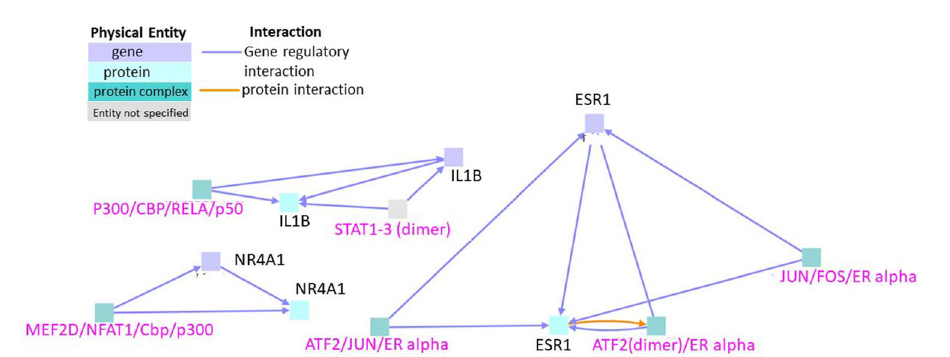
Figure 5. Interactions between genes that are upregulated exclusively in cardiotoxicity. Black labels denote seed nodes and pink labels denote intermediate nodes. Each line represents an interaction. Grey square (STAT1-3 dimer) indicates that the entity whether gene/protein/compound etc. was not specified by the